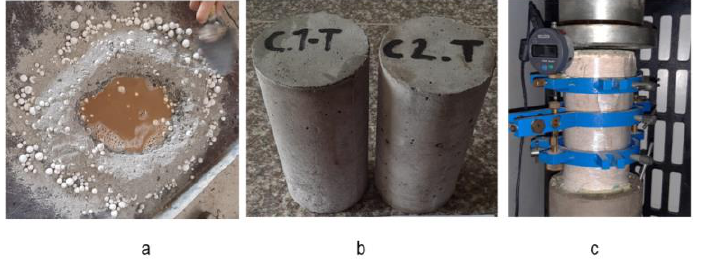
Figure 3. Sequence of final activities: ( a ) mixing of materials, ( b ) conformation of concrete cylinders, and ( c ) elastic modulus test.